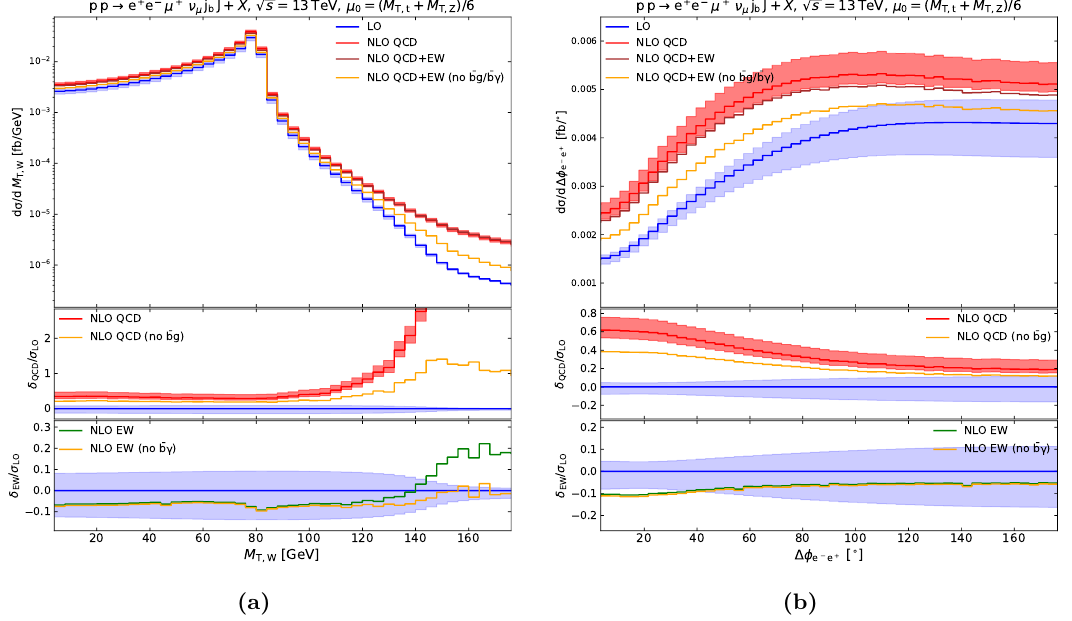
Figure 9. Transverse-mass distribution of the W boson as defined in eq. (3.7) and azimuthal- angle-separation distribution of the e + e −